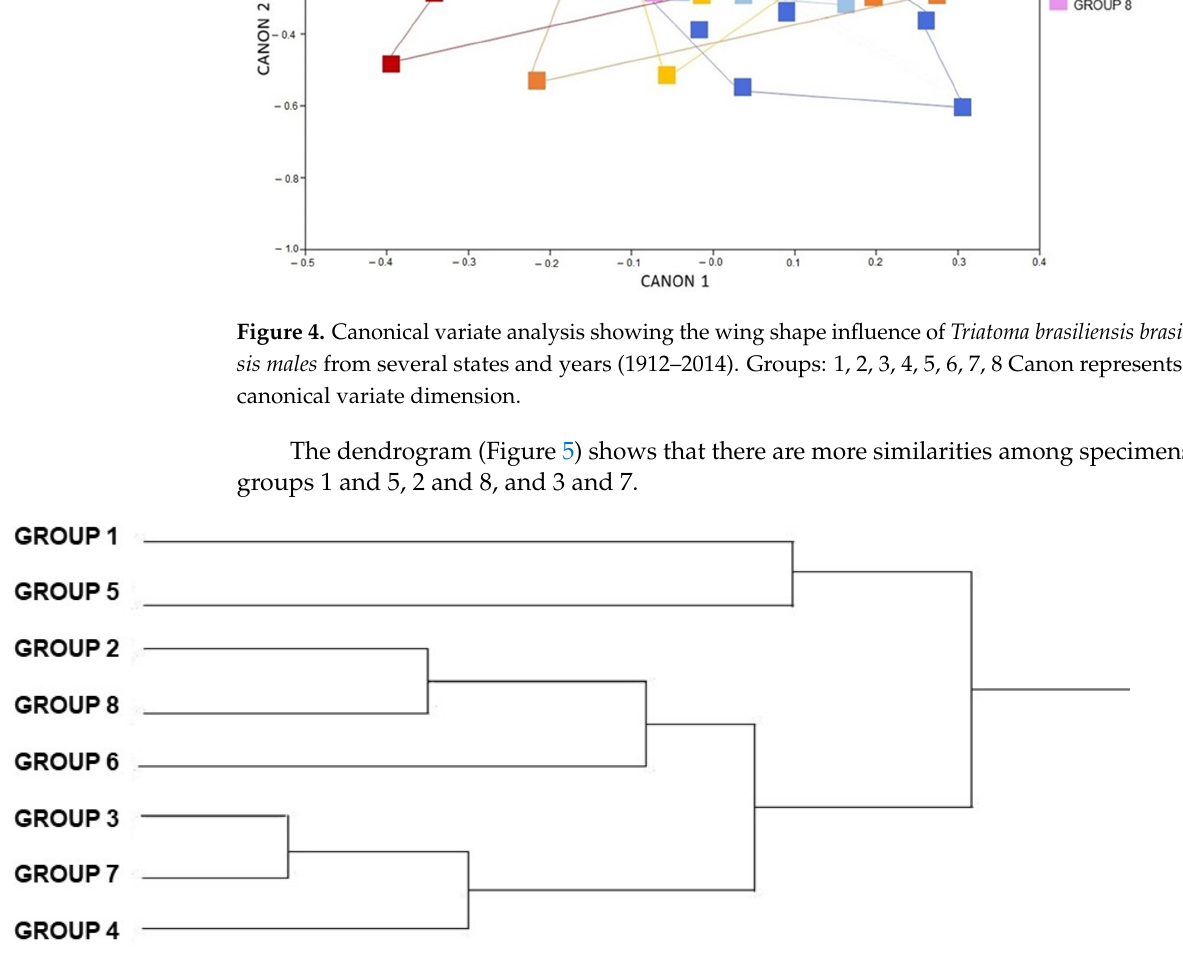
Figure 5. UPGMA Dendrogram of the Triatoma brasiliensis brasiliensis males, from various states and years (1912–2014), showing the phylogenetic distances between the